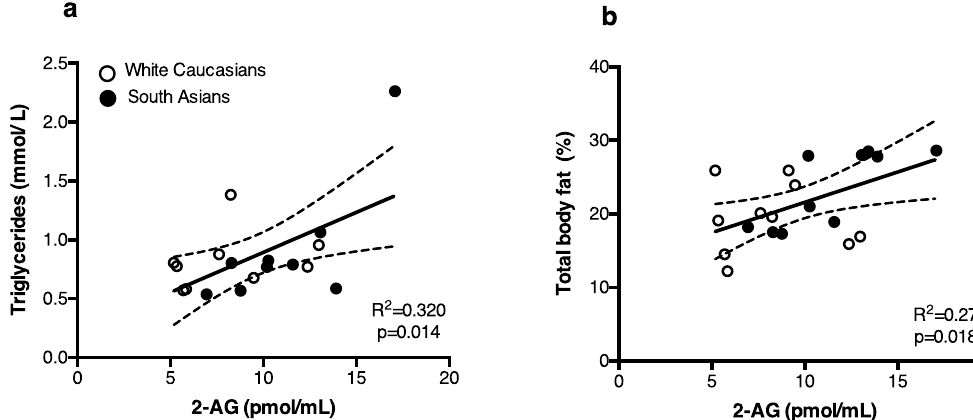
Figure 2. Thermoneutral plasma 2-AG levels positively correlate with serum triglyceride levels and total body fat percentage. Scatterplot of the correlations between 2-AG levels and serum TG ( a ) or total body fat percentage ( b ). Correlations are shown for the total group combined (n = 20), white circles are white Caucasian individuals (n = 10) and black circles are South Asian individuals (n = 10), with 95% confidence limits. Correlations were analysed using linear regression analysis.